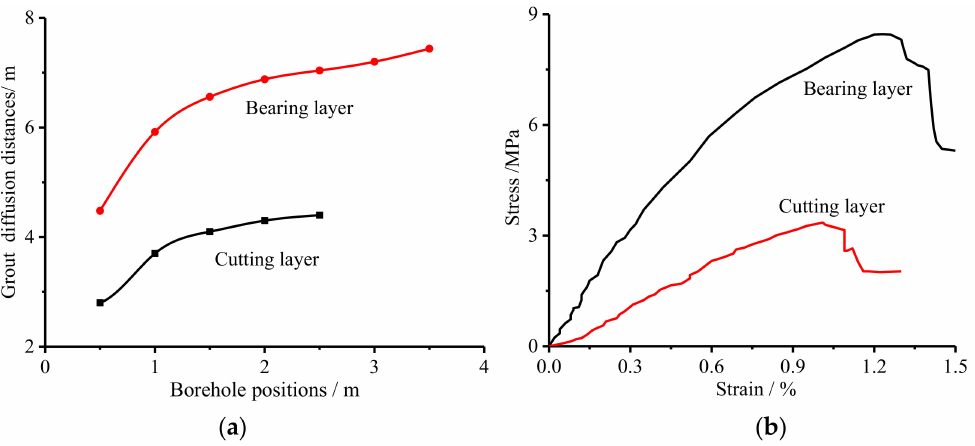
Figure 15. ( a ) Diffusion distances of the grout at different positions; ( b ) Stress-strain curves of the core specimens.